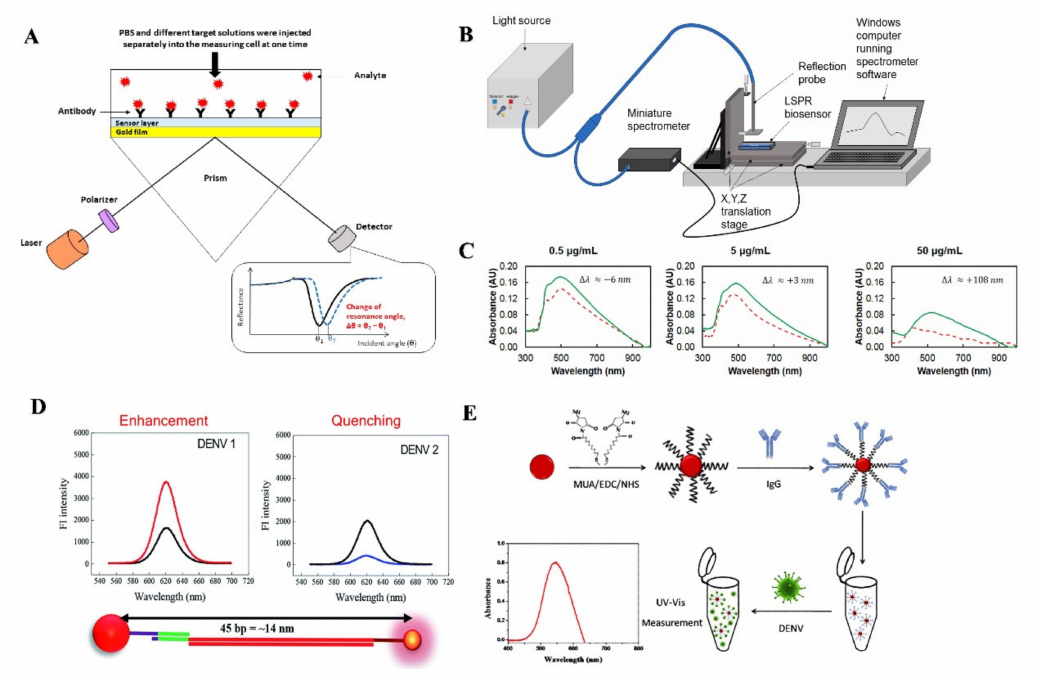
Figure 5. Detection of DENV viral biomarkers using surface plasmon resonance technologies. ( A ) An Au thin film based graphene oxide-polyamidoamine dendrimer based SPR sensor mechanism represents to measure the change in the SPR angle in present of DENV viral proteins (Reprinted from [128]). ( B , C ) Silver nanostructured SPR biosensor experimental setup to detect different concentration of NS1 antigen by measuring the peak wavelength shift on the chamber of a nanostructured device. NS1 antigen (green solid line), and anti-NS1 antibody (red dashed line) (Reprinted with permission from ref. [130]. Copyright 2019 Elsevier.). ( D ) Detection of different DENV serotypes based on altered distance based fluorescence signal (LSPR Enhancement and quenching) generated by primer–probe conjugated quantum dots and AuNPs (Reprinted from [133]). ( E ) AuNPs surface was modified by a self-assembled monolayer of MUA which facilitated covalent bonding of the DENV specific antibody with the AuNPs. (Reprinted with permission from ref. [134]. Copyright 2018